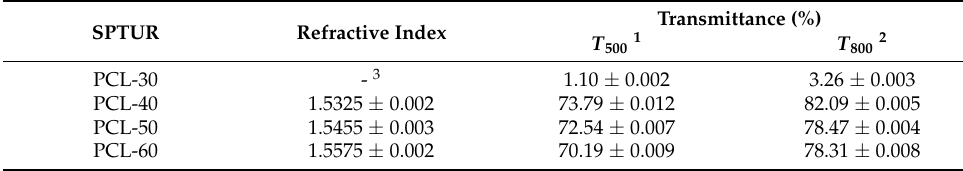
Table 7. Refractive index and transmittance of